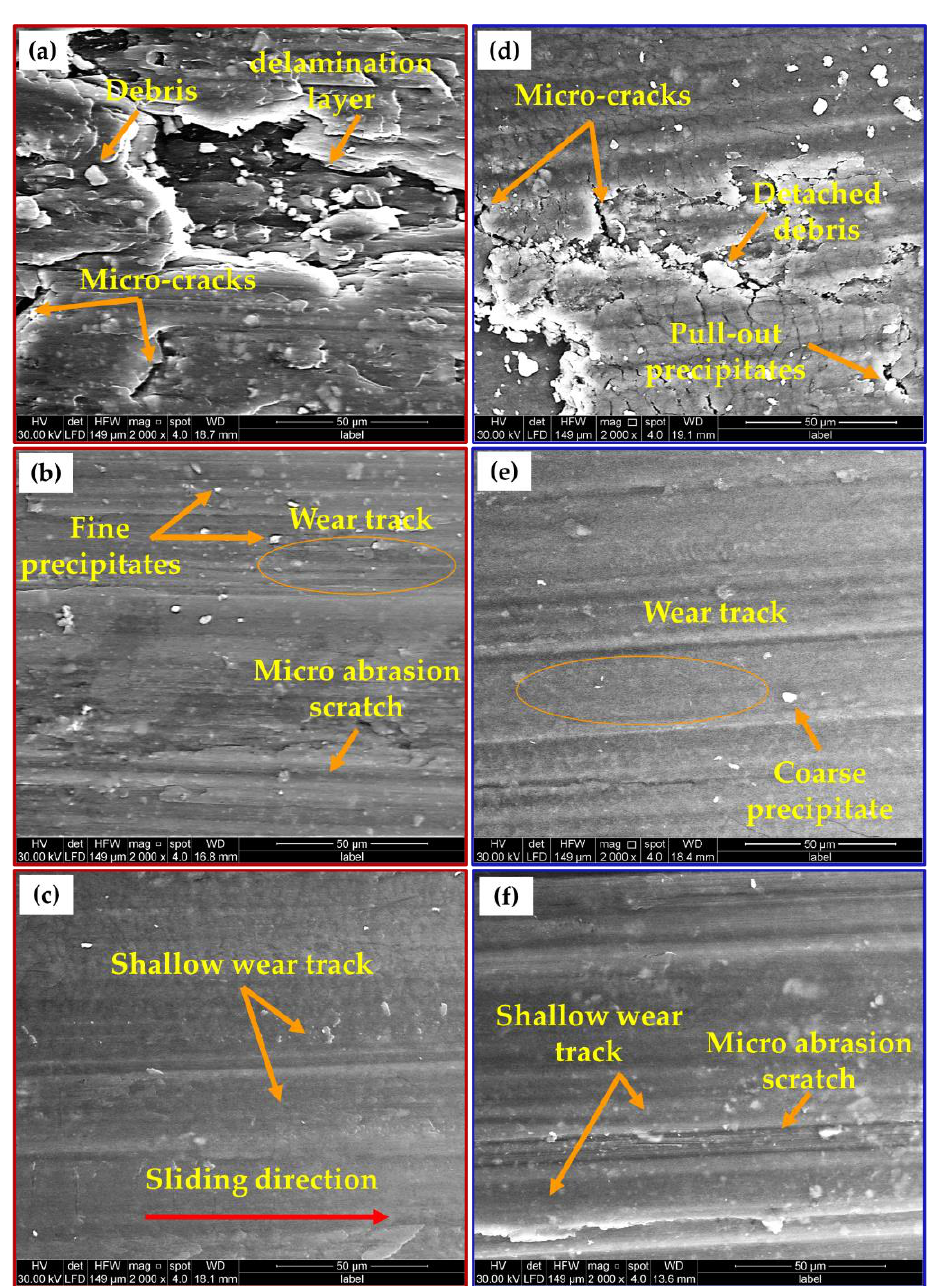
Figure 19. SEM images of the worn surface of the initial materials, AMPs, and AMCPs: ( a – c ) T6 and ( d – f ) O temper conditions, respectively. ( d – f ) O temper conditions,